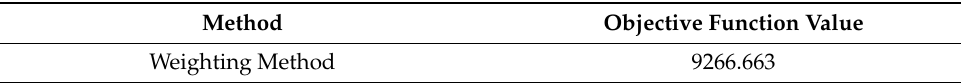
Table 17. The exact solution of the model obtained by the weighting method.